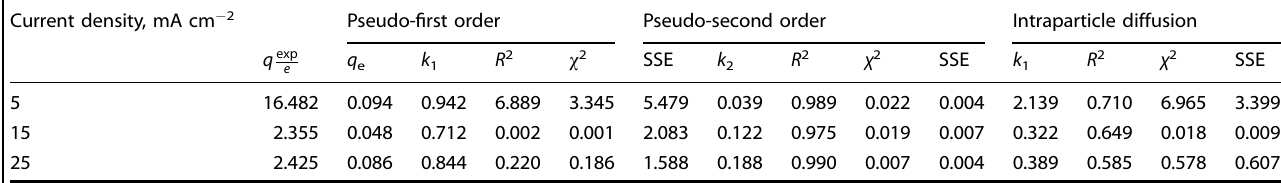
Table 1. Parameters for the effect of current density on the cadmium adsorption kinetics. Current density, mA cm −